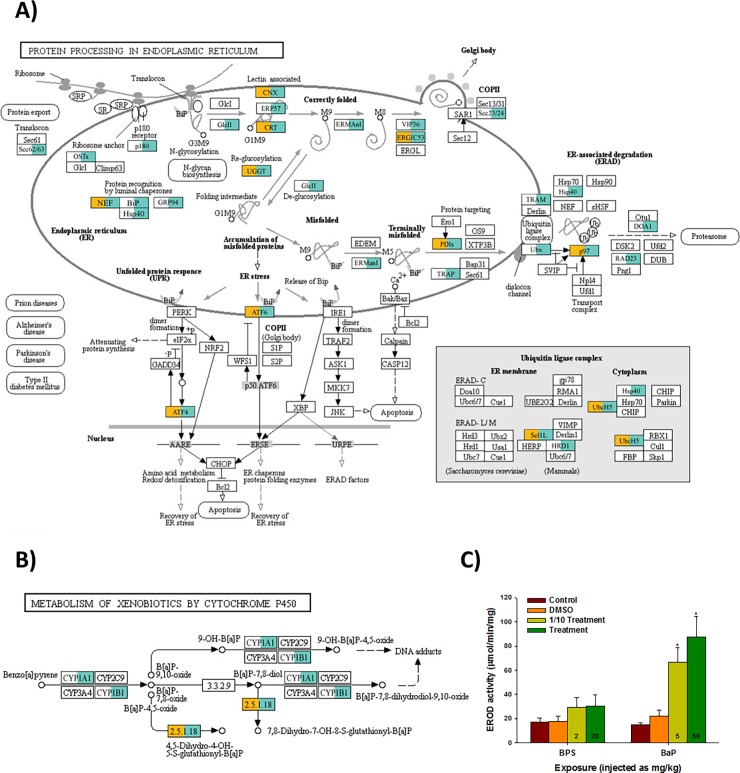
Comparison of KEGG pathways with mapped genes.(A) “Protein procession in endoplasmic reticulum” and (B) Benzo[a]pyrene metabolism in “Metabolism of xenobiotics by cytochrome P450” in the BPS- or BaP-exposed liver tissues of P. olivaceus. The orange color denotes the gene mapped from the BPS-exposed liver transcriptome to each KEGG pathway. The blue-green color denotes the gene mapped from the BaP-exposed liver transcriptomes to each KEGG pathway. Notably, no gene was solely mapped from the BPS-exposed liver transcriptome to a KEGG pathway. (C) The hepatic EROD activity in the liver tissue of BPS- or BaP-injected olive flounder. Data are presented as the mean ± standard deviation (S.D.). Significant differences from the control value are indicated by an asterisk (*) on the data bar (P < 0.05).